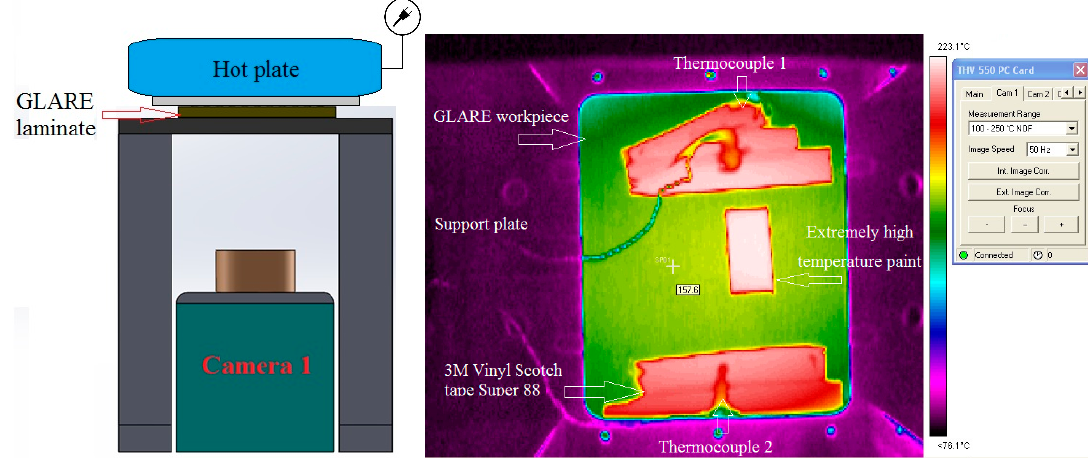
Figure 2. Determination of GLARE emissivity in the second test.